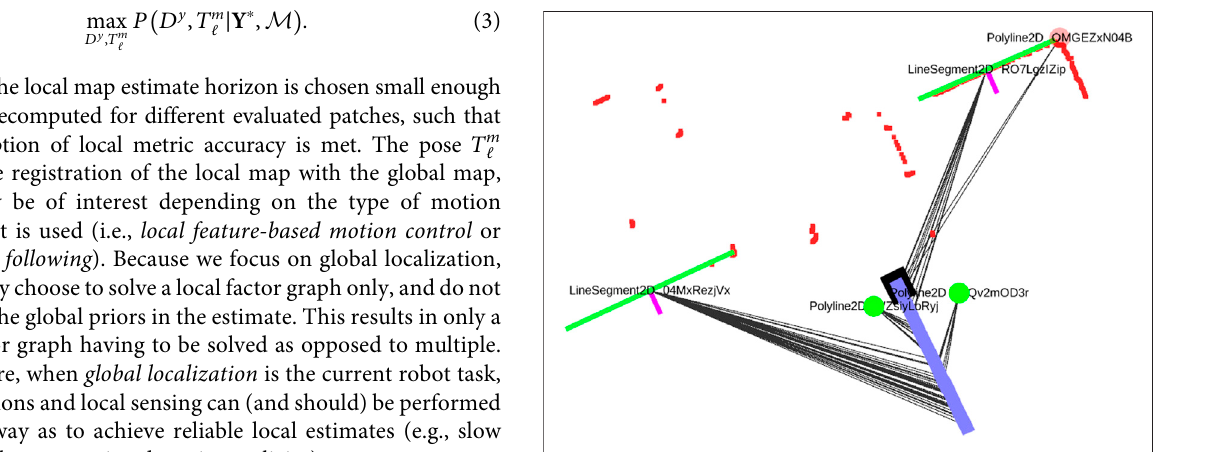
FIGURE 2 | A small locally consistent map of line and corner features, that has been obtained by locally associating and merging feature representations and solving the factor graph optimization problem after each new LiDARscanisobtained. Therobotposes areshowninblue withthe current pose in black. measurementassociations are shown asgrey lines and current LiDAR points in red. The line measurements include a normal to indicate their visible side. A corner detection is shown in translucent red when not enough measurements have been associated with it (candidate detection). The features get assigned unique string identi fi